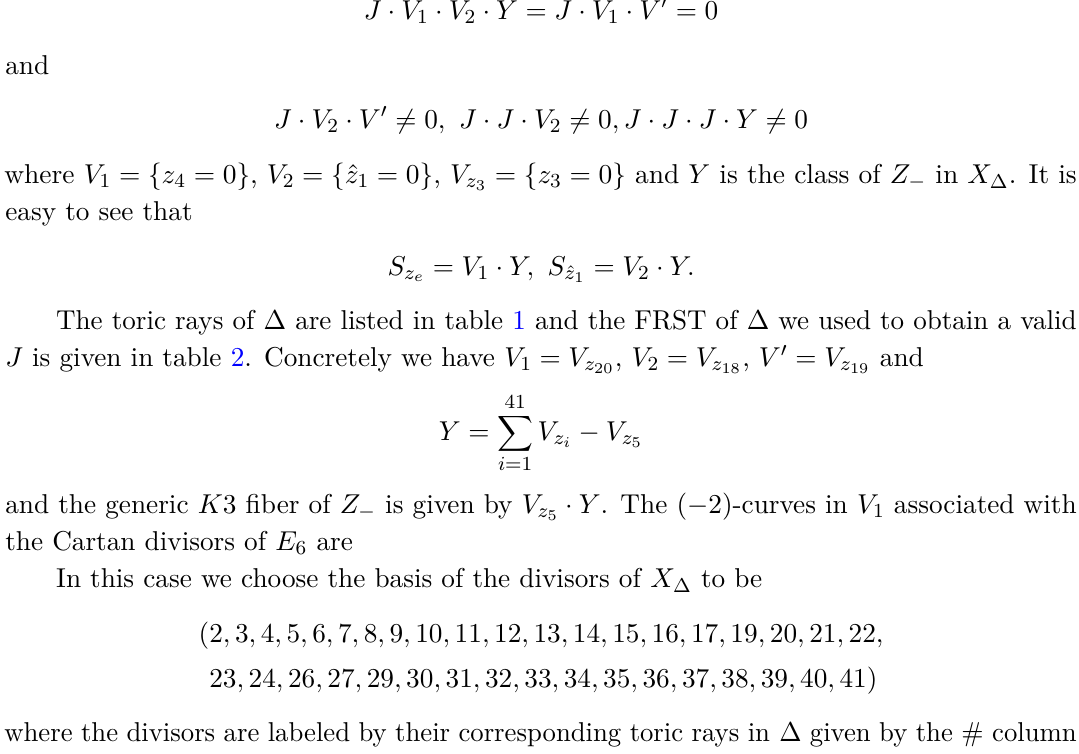
represents the ray v = (2 , 3 , 0 , 0) . 0 z 0 . For the triangulation in figure 4, S ∪ S z e ˆ z 1